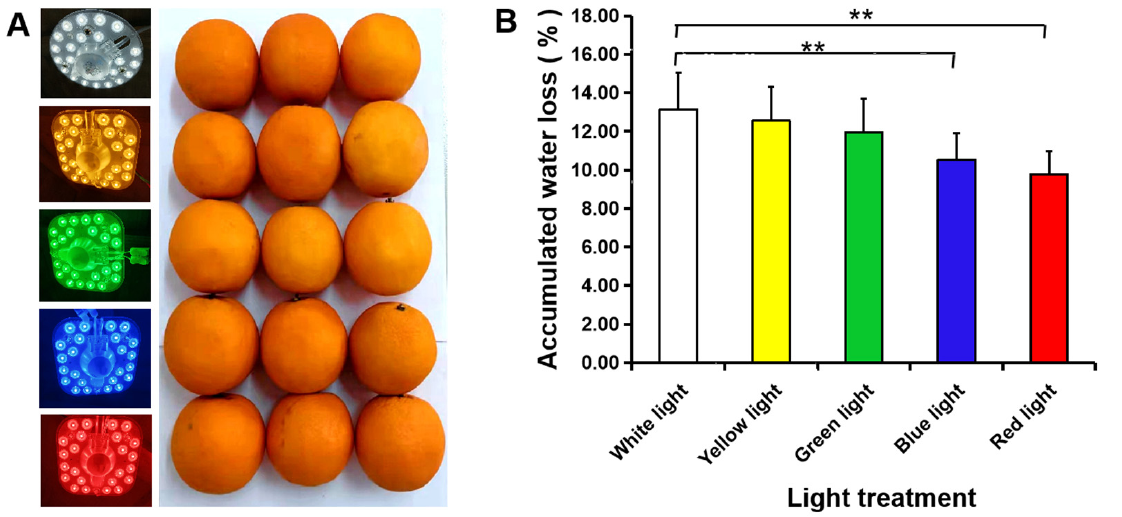
Figure 8. Illumination with blue or red LED light inhibited water loss in navel orange fruit. ( A ) Fruit phenotypes (right) after 21 d of different LED light treatments (left). ( B ) The accumulated water loss per fruit after 21 d of light illumination. The error bars represent the mean ± SD ( n = 10). **, p < 0.01.